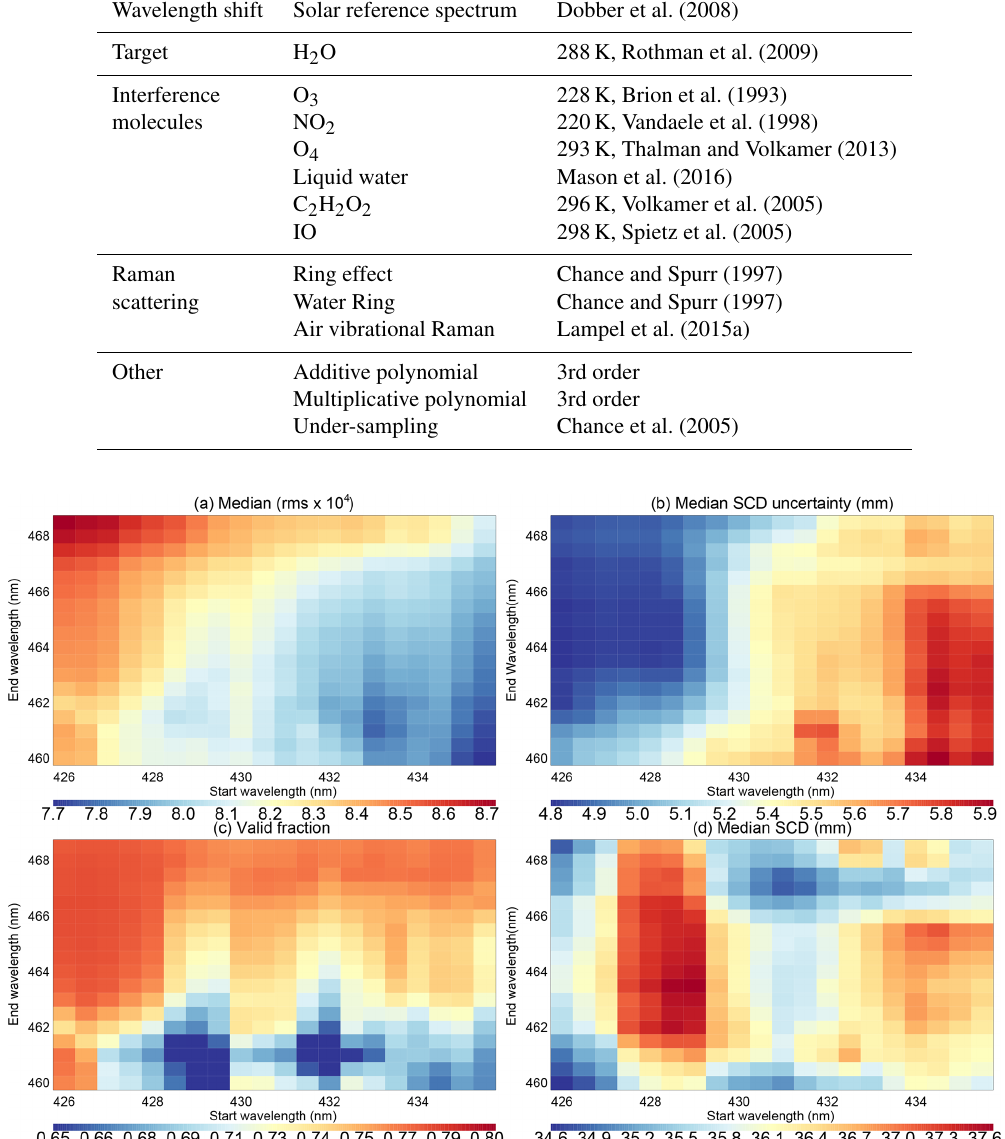
Figure 1. Sensitivity of the retrieval to the start and end wavelengths (nm) of the retrieval window for OMI Orbit 10426. (a) Median of fitting RMS × 10 4 ; (b) median of water vapor SCD fitting uncertainty in millimeters; (c) valid fraction for retrievals; (d) median SCD in